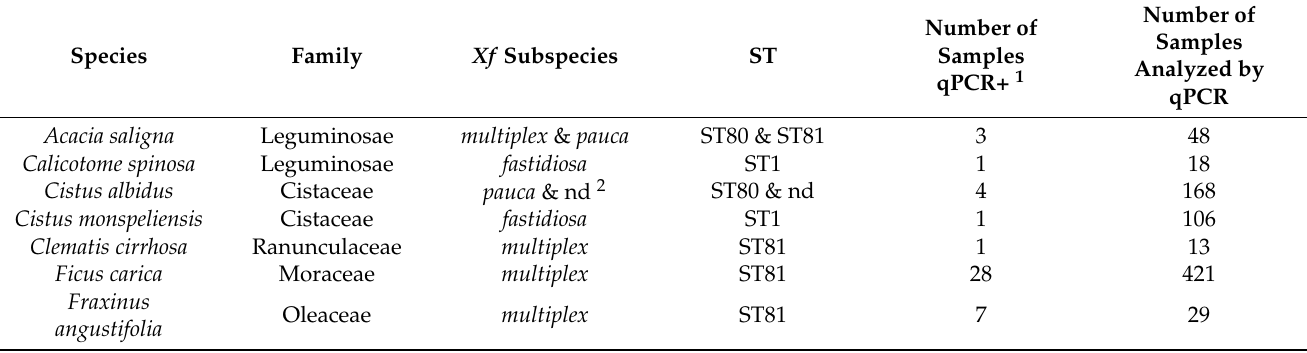
Table 1. List of hosts infected by Xylella fastidiosa in the Balearic Islands updated to December